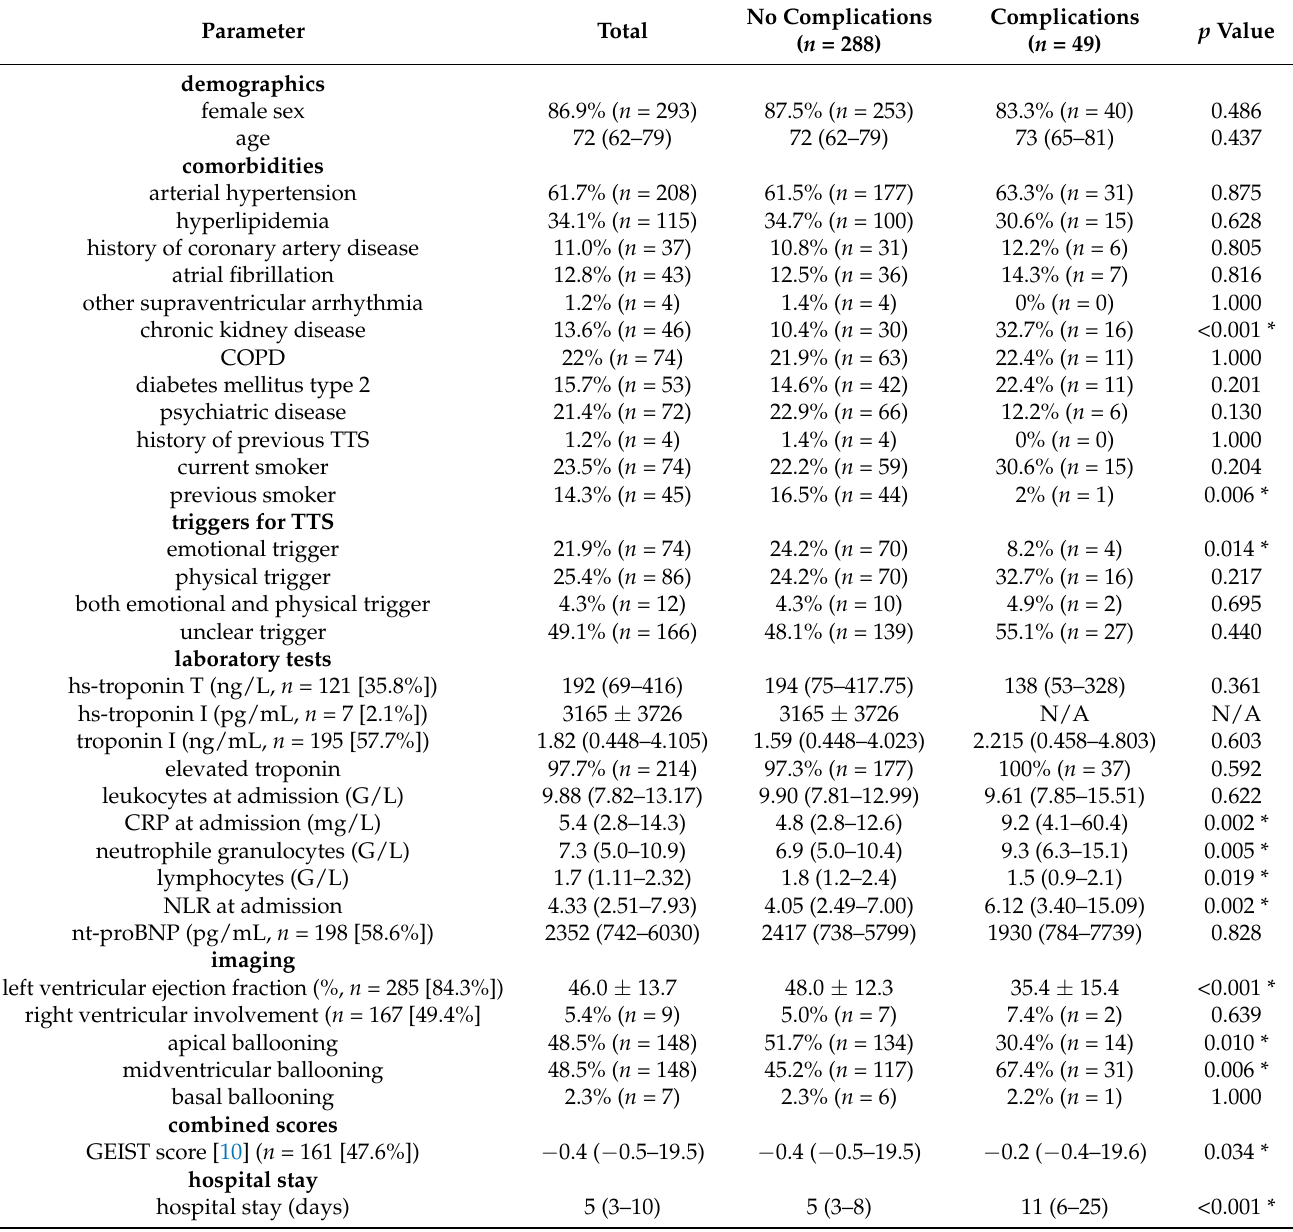
Table 1. Baseline characteristics of the total study population and stratified by subgroups based on oc- currence of severe in-hospital complications. Severe in-hospital complications were all complications requiring immediate invasive therapy or leading to irreversible